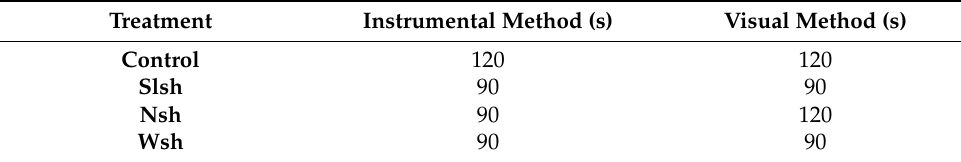
Table 1. Optimal cooking time for each pasta in both types of